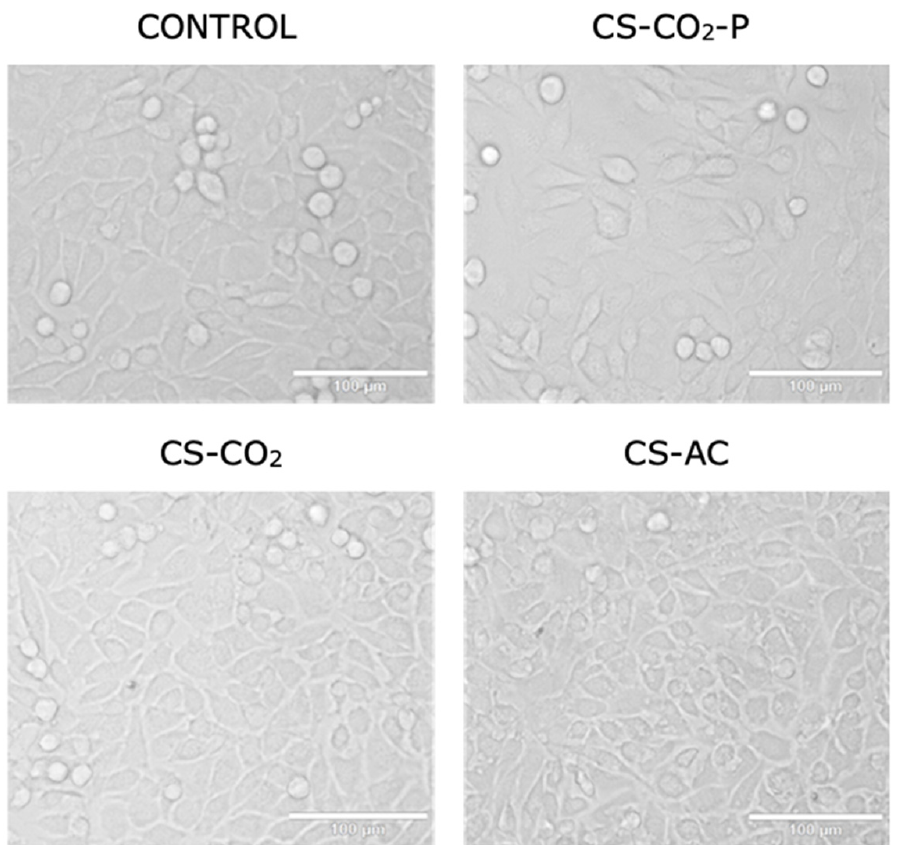
Figure 5. Representative image at 200 × magnification of L929 cells following 24 h of treatment with chitosan hydrogels: CS-CO 2 , CS-AC, and CS-CO 2 - p at 1:3 diluent factor. The scale bar is 100 µm.